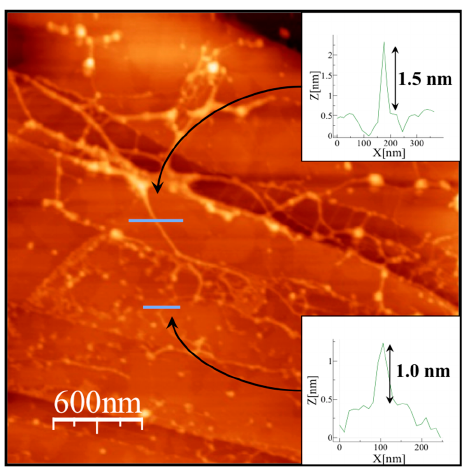
Figure 6. Topographic AFM image of an aqueous solution of 1D-CP(Cd) − material drop-casted on a mica substrate. The insets show the height profiles highlighted on the image, indicative of the presence of 1D-CP(Cd) − consisting of 2–3 chains.